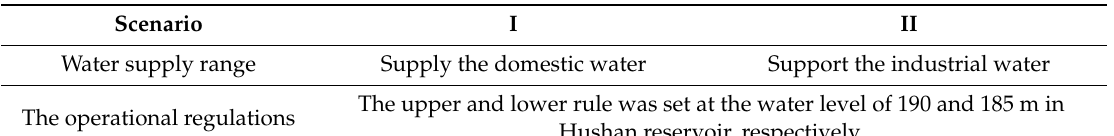
Figure 6. Water supply system of Hushan reservoir.